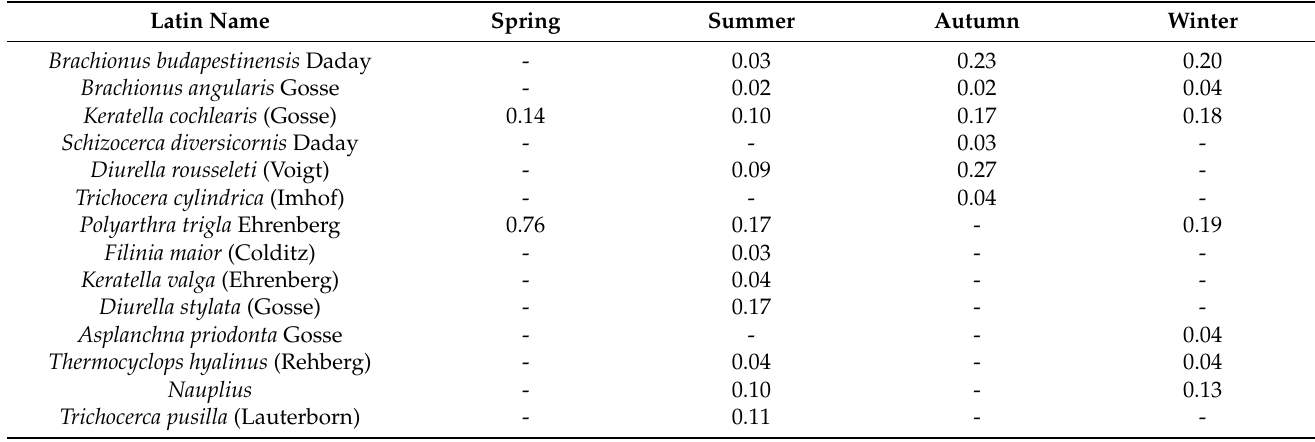
Table 3. Dominant species and dominance of zooplankton in Lake Feng